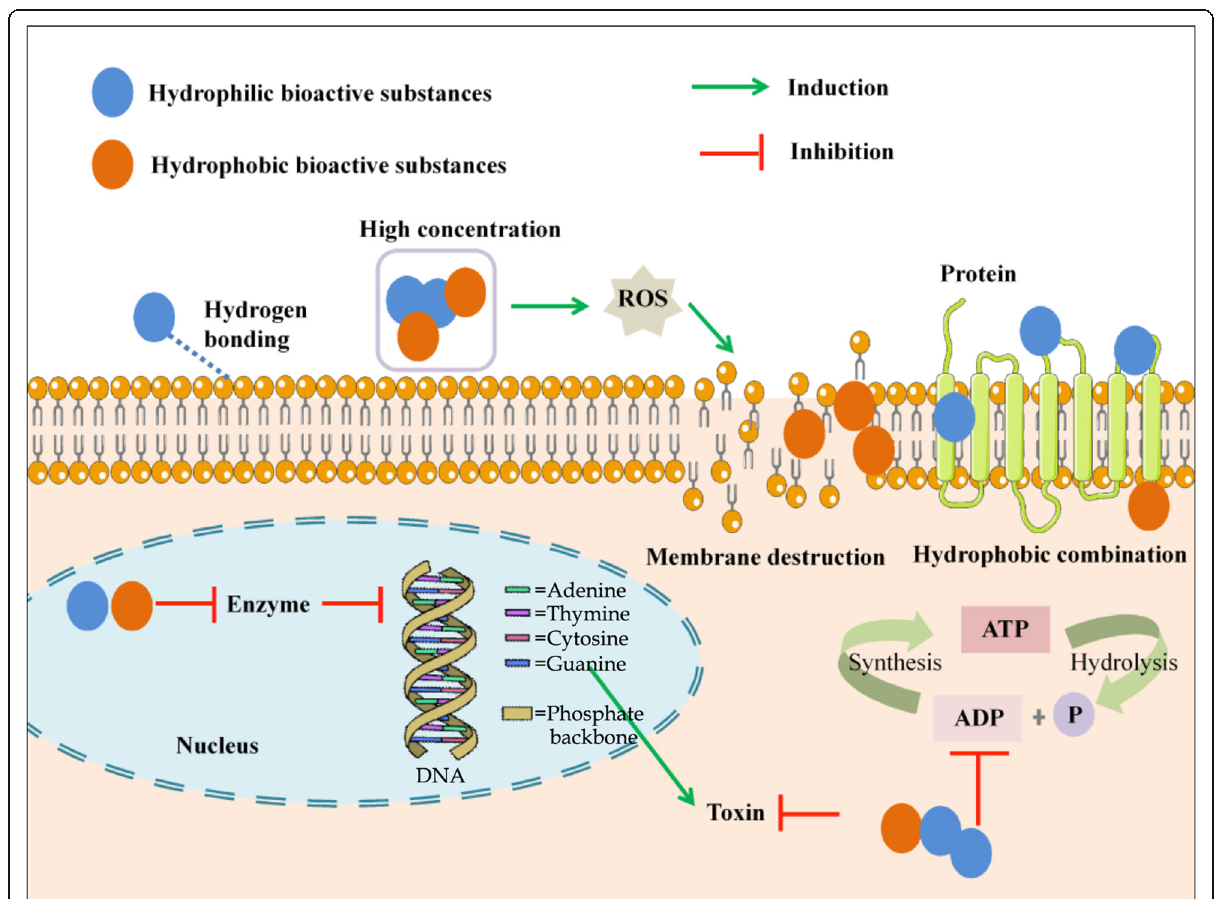
Fig. 1 Mechanism of anti-bacterial and anti-fungal effects of natural bioactive